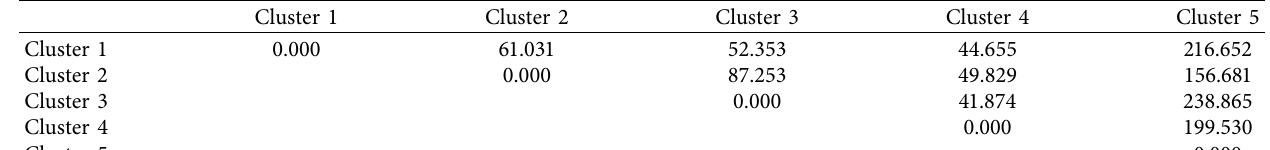
Table 8: Distances between cluster centroids.